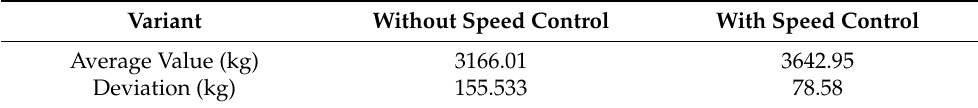
Figure 7. Distribution of the change in the material weight of the bucket conveyor: (a) without speed control, (b) with speed control [22]. Table 3. Weight of material on the conveyor without and with the control system